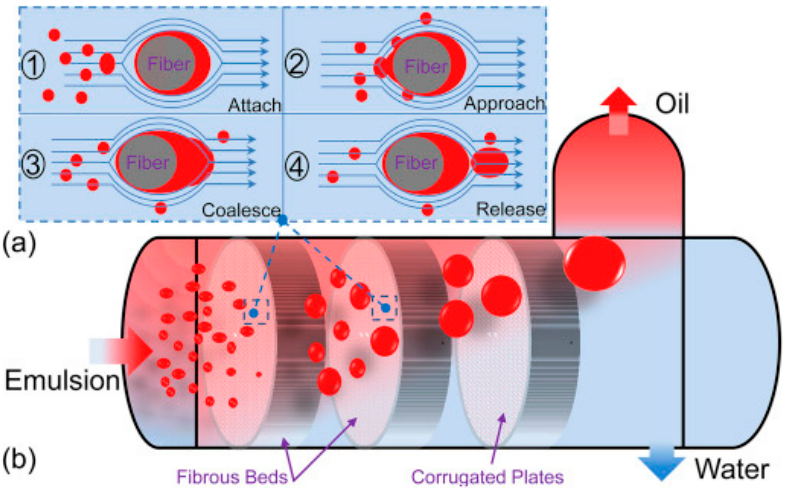
Figure 6. Novel coalescer design using fibrous beds. Reprinted with permission from ref. [113]. Copyright 2019 Elsevier B.V. ( a ) the coalescer separation process divided into four phases (1) attach (2) approach (3) coalesce and (4) release and ( b ) the coalescer structure.